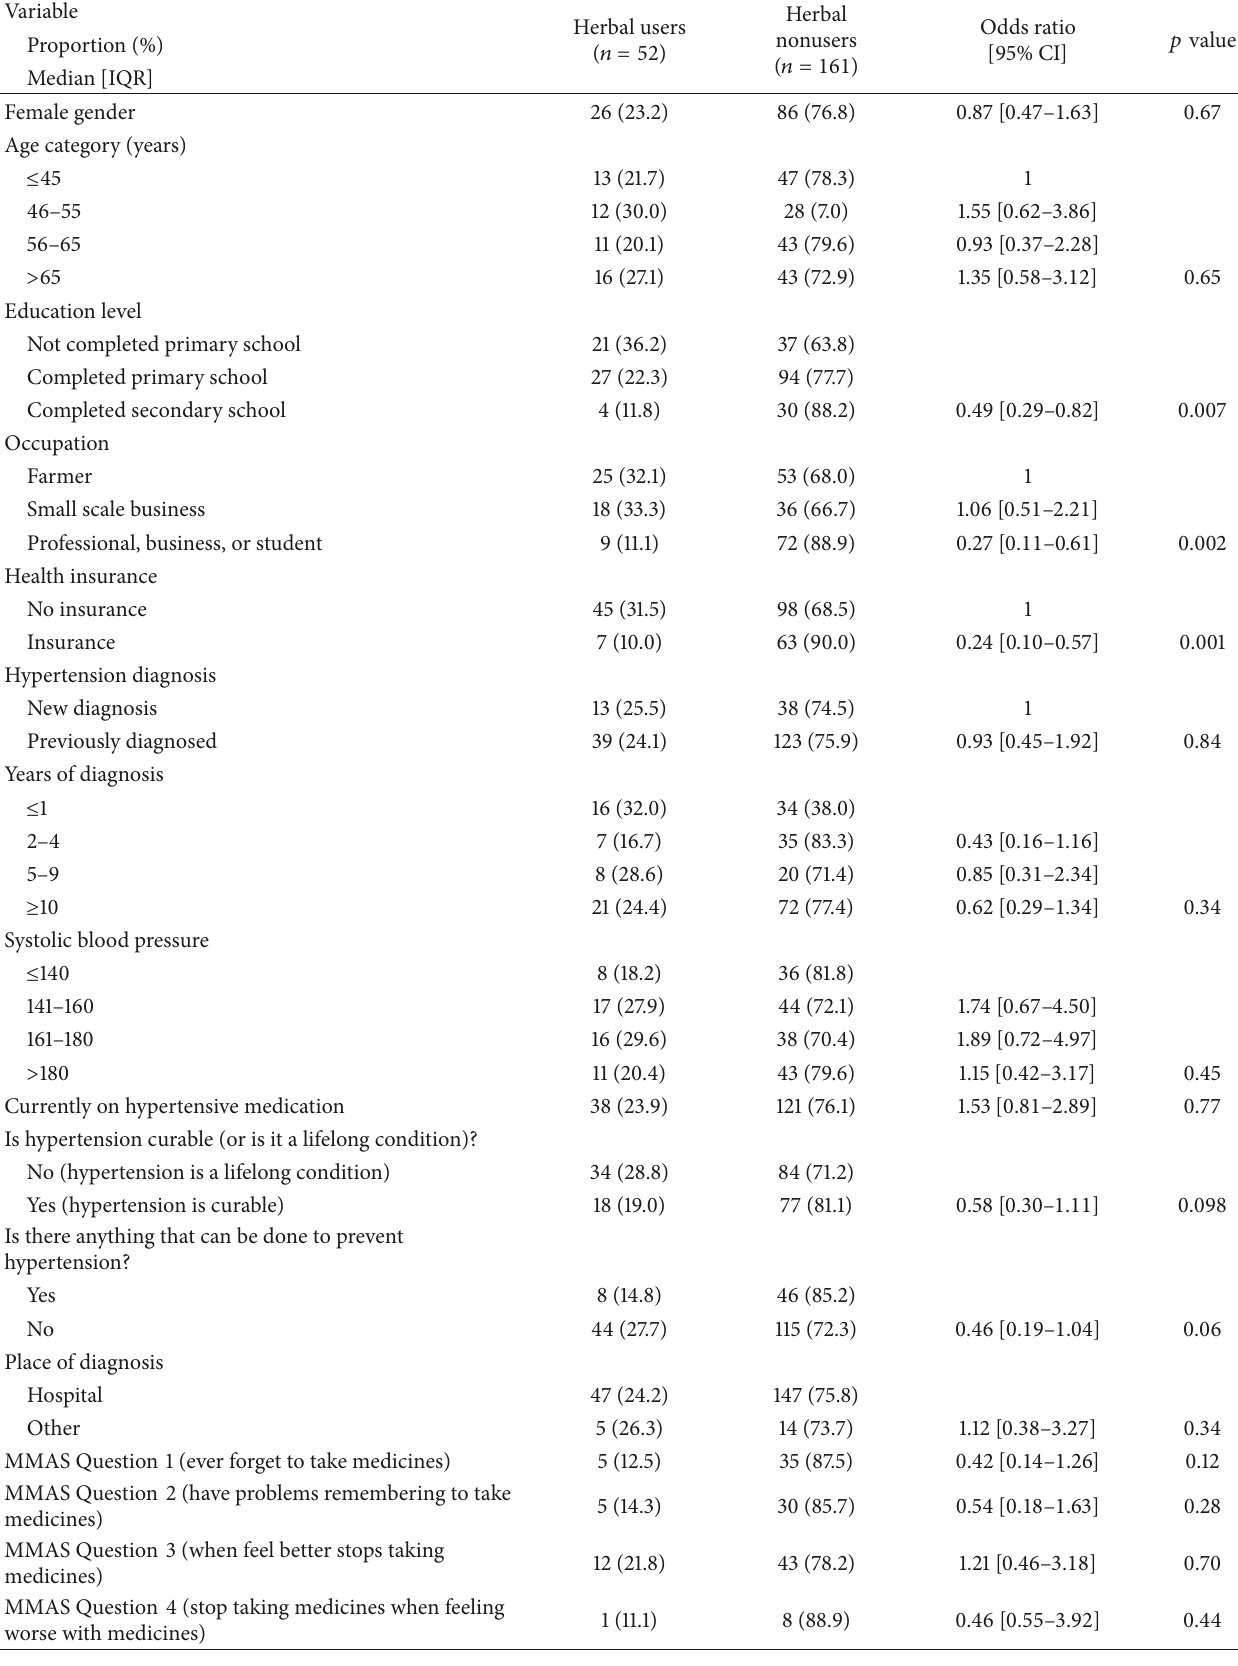
Table 3: Characteristics and factors associated with the current use of herbal medicine in the month prior to hospital